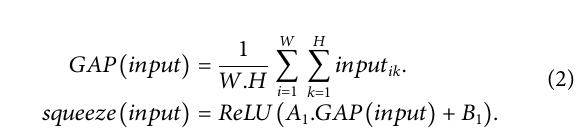
Frontiers in Signal Processing |